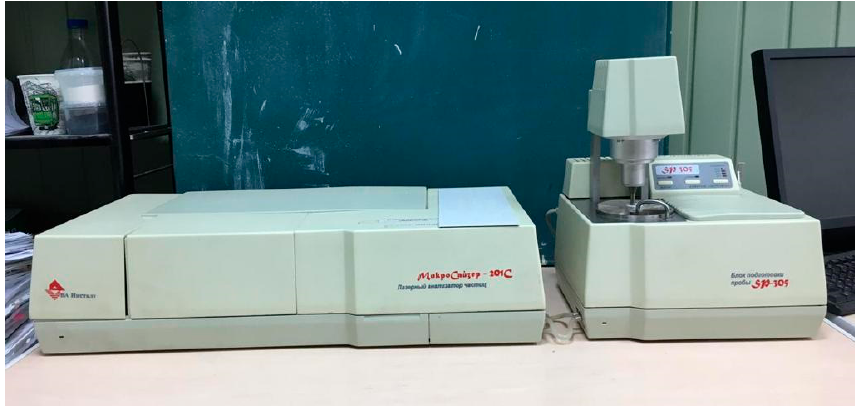
Figure 3. Laser particle analyzer Microsizer 201C.